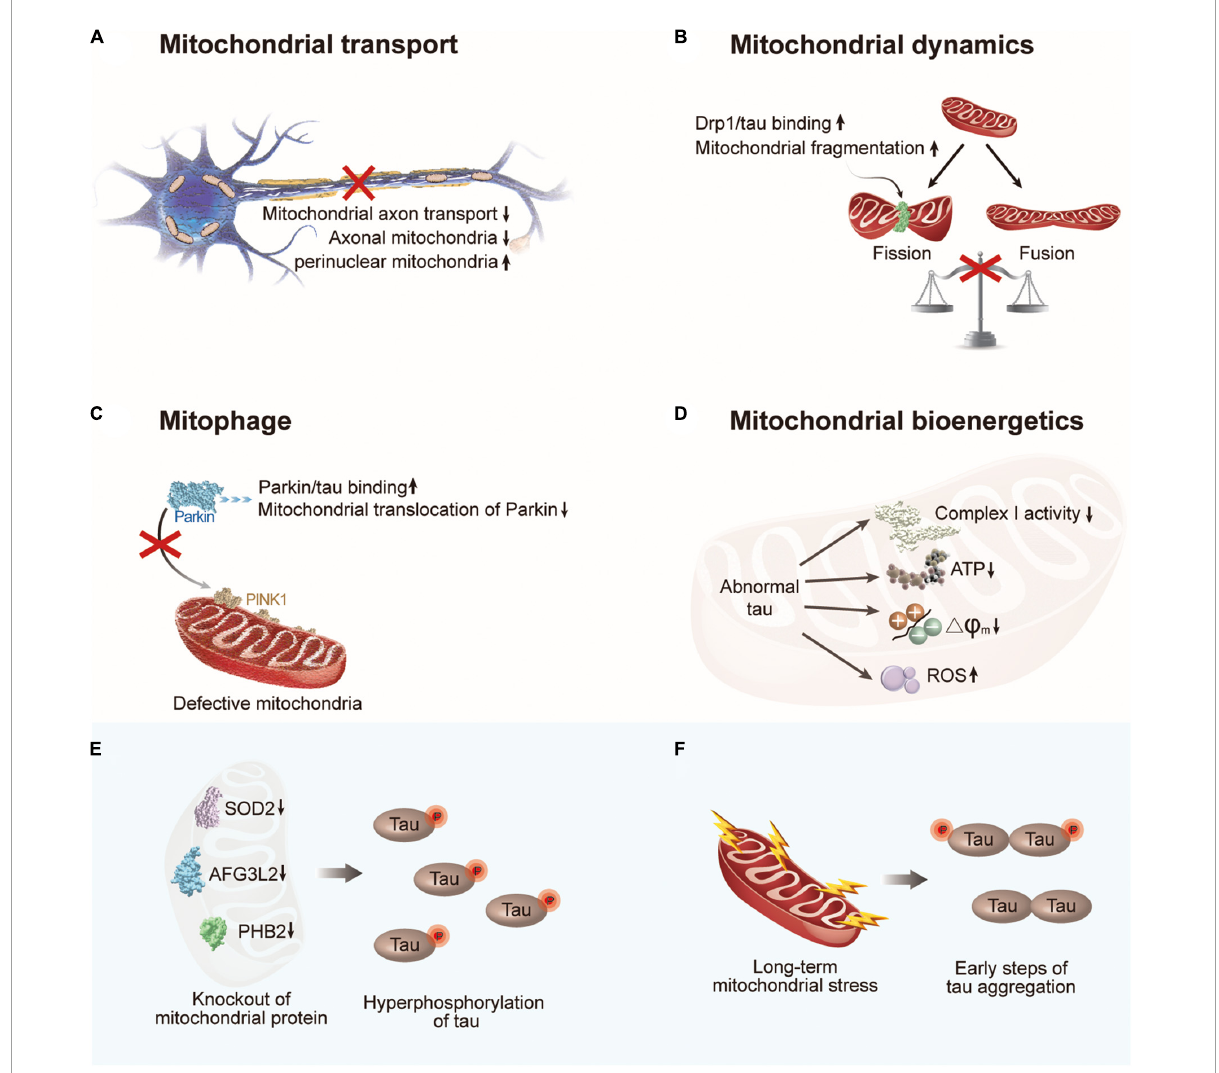
FIGURE3 The crosstalk between abnormal tau and mitochondrial dysfunction. (A) Abnormal tau impairs axonal transport of mitochondria with a decrease in the number of axonal mitochondria and an increase in perinuclear mitochondria. (B) Abnormal tau disturbs mitochondrial fission/fusion dynamics through interacting with Drp1, resulting in enhanced mitochondrial fission. (C) Abnormal tau impairs mitophagy by interacting with Parkin to prevent Parkin translocation to defective mitochondria. (D) Abnormal tau impairs mitochondrial bioenergetics via inhibiting complex I activity, reducing ATP levels and (cid:49)(cid:57) m, and increasing ROS generation. (E) Hyperphosphorylation of tau can be induced by deficiency of mitochondrial protein SOD2, AFG3L2, or PHB2. (F) Long-term mitochondrial stress induces tau dimerization. Drp1, dynamin-related protein 1; PINK1, PTEN-induced putative kinase 1; SOD2, superoxide dismutase 2; AFG3L2, AFG3 like matrix AAA peptidase subunit 2; PHB2, prohibitin